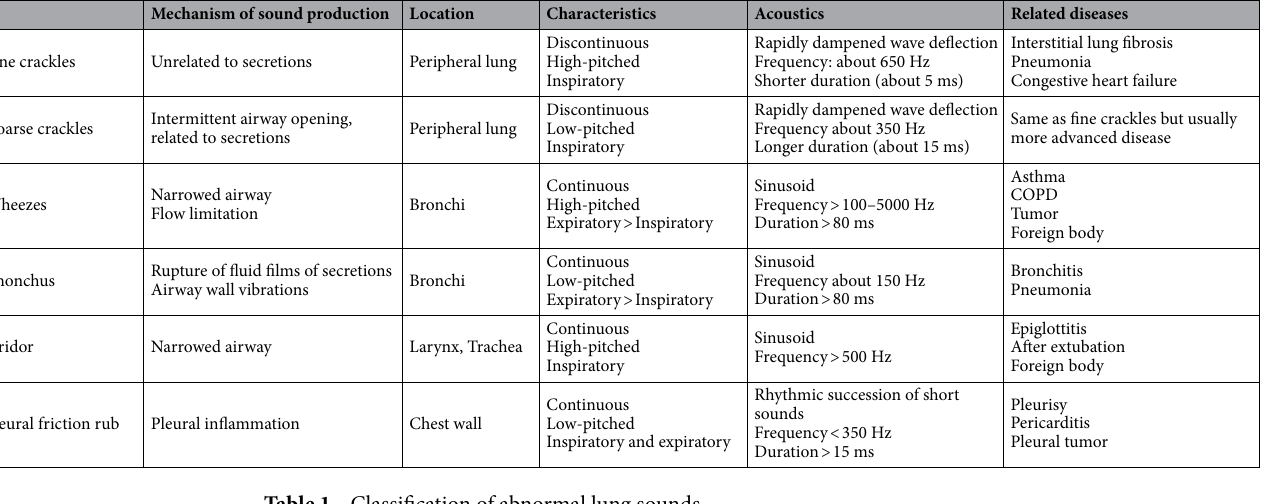
Table 1. Classification of abnormal lung